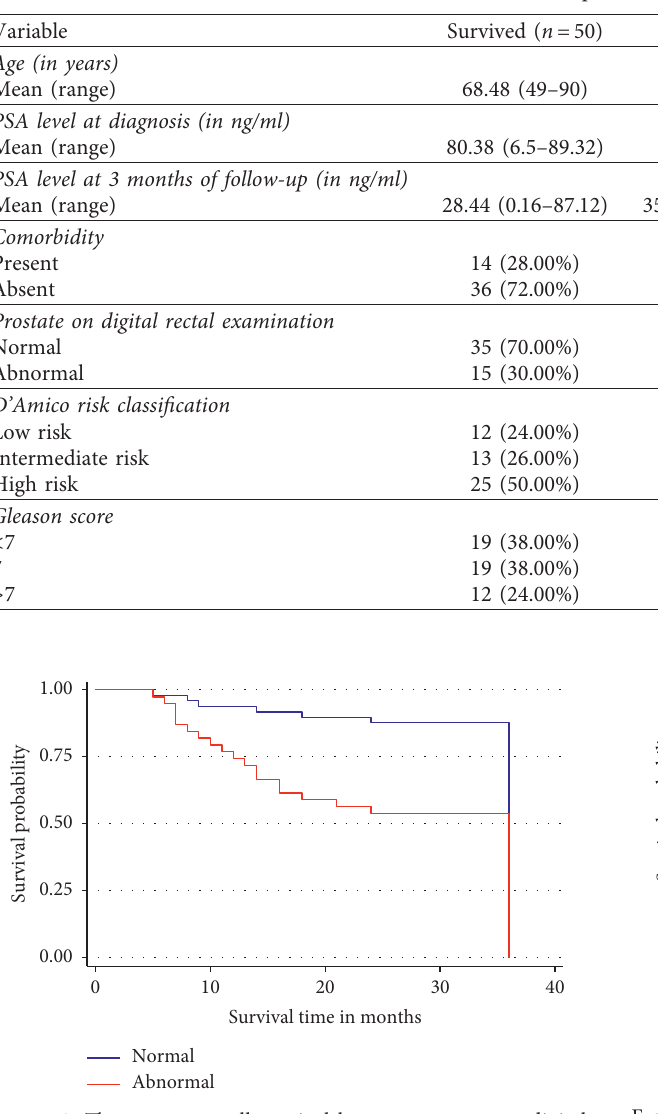
Figure 2: Three-year overall survival by prostate state on digital rectal examination of the patients. Patients with abnormalities show a relatively increased risk of dying compared to those without abnormalities.